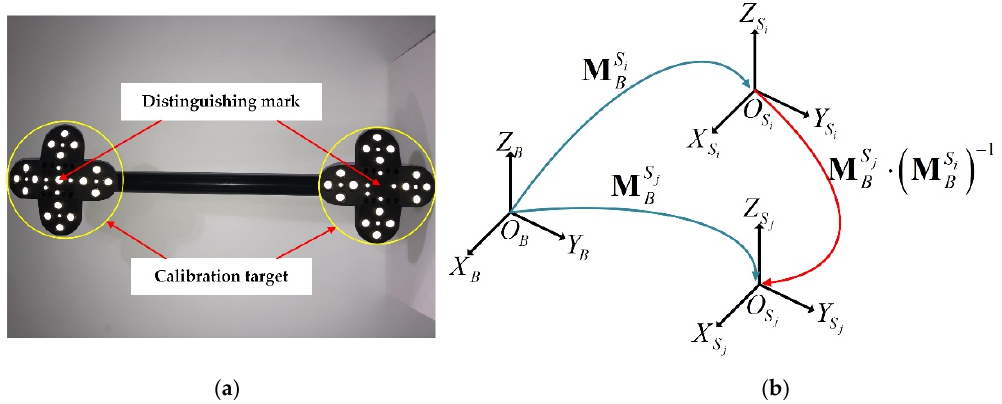
Figure 3. Pose transformation calibration for two adjacent sensors: ( a ) handheld target calibration rod; ( b ) calibration dia- gram.